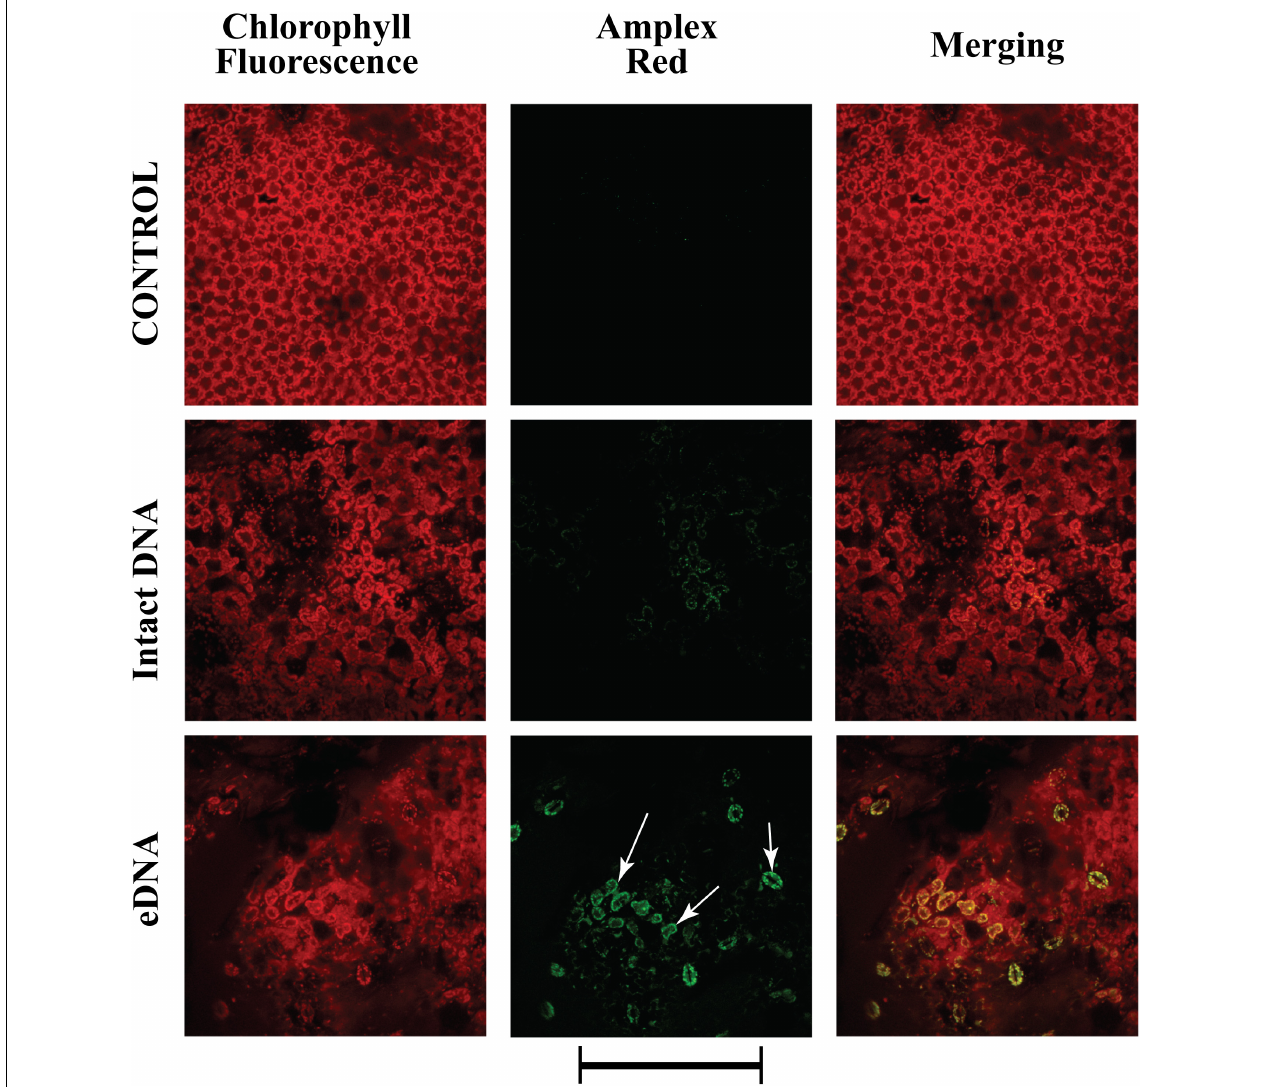
FIGURE 5 | Intracellular variations of H 2 O 2 production in tomato leaves in controls (no treatment) and upon treatments with tomato intact DNA and eDNA. The Amplex R (cid:13) Red reagent, in combination with horseradish peroxidase (HRP), was used to detect H 2 O 2 released or generated in enzyme-coupled reactions. False-color image analysis reconstructions from confocal laser-scanning microscope observations, fluorochemical H 2 O 2 , and peroxidase localization. Fifty microliters of 200 µ g ml − 1 of either eDNA or intact DNA were applied and after 180 min the ROS signature was observed in close association with chloroplasts (arrows). Pictures represent portions of the tomato leaf blade where the green fluorescence refers to the binding of Amplex R (cid:13) Red with peroxidase-produced H 2 O 2 , whereas the chloroplasts are evidenced by a bright red color caused by chlorophyll fluorescence. Scale bar (250 µ m) is indicated at the bottom of the figure. Pictures are the results of the merging of 25 individual optical